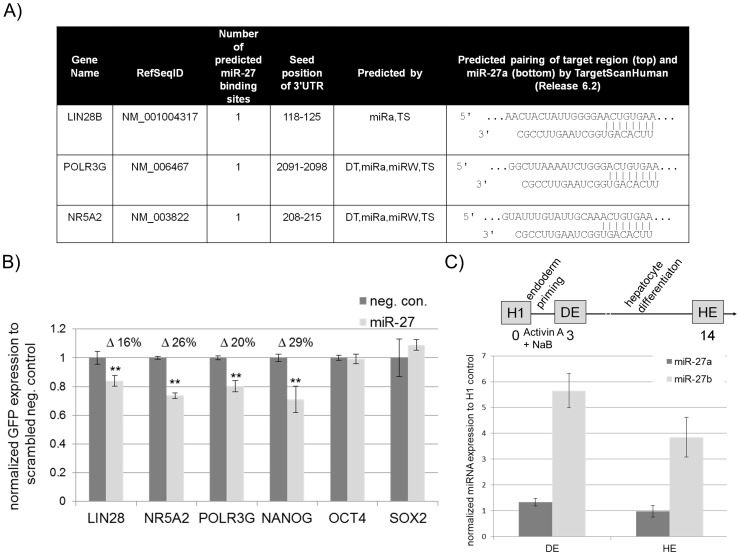
miR-27 directly inhibits a number of genes reported to sustain self-renewal in embryonic stem cells.(A) Table showing three putative miR-27 target genes predicted by Diana Micro-T (DT), MiRanda (miRa), MirWalk (miRW) and TargetScan that maintain self-renewal. (B) Normalized GFP expression (48 hours post transfection) of HEK293 cells co-transfected with EGFP-sensors bearing parts of the 3′-UTR of LIN28B, NR5A2, POLR3G, NANOG, SOX2 or OCT4 together with either miR-27 mimics or a scrambled negative control mimic (neg. con.). All transfections were performed twice in biological triplicates (n = 6) and GFP expression measured by flow cytometry. An unpaired two tailed t-test was performed to reveal significant differences (** p<0.01). (C) Upper row: Schematic timeline of hESC (H1) undergoing hepatic differentiation. Total RNA was isolated at day zero (undifferentiated H1), three days after endoderm priming (DE) and 14 days after hepatocyte differentiation (HE). Lower row: miR-27 expression was carried out for miR-27a and miR-27b using TaqMan-based PCR on total RNA samples from the above described stages, DE and HE and normalized to the untreated/undifferentiated H1 control.